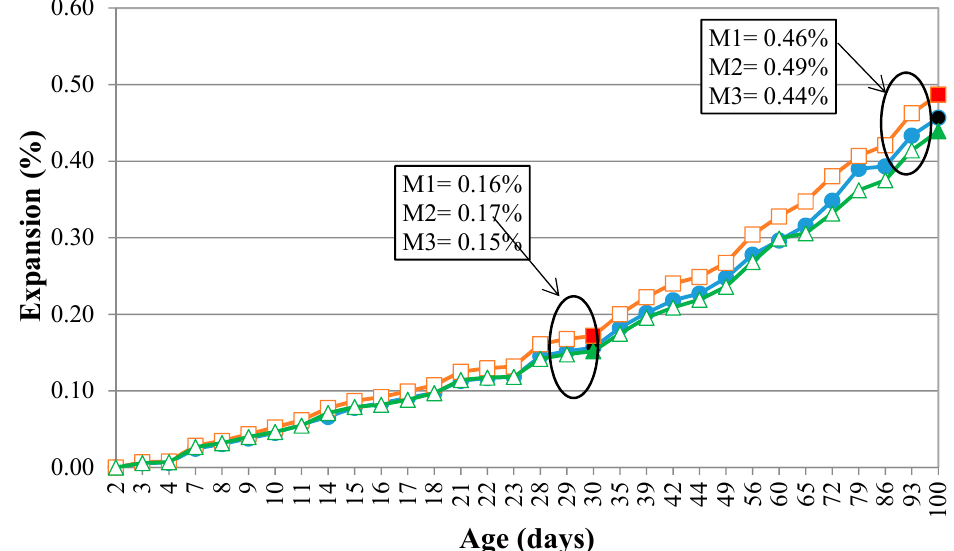
Figure 11. Expansion of the M1, M2, and M3 in the mortar bar accelerated test.